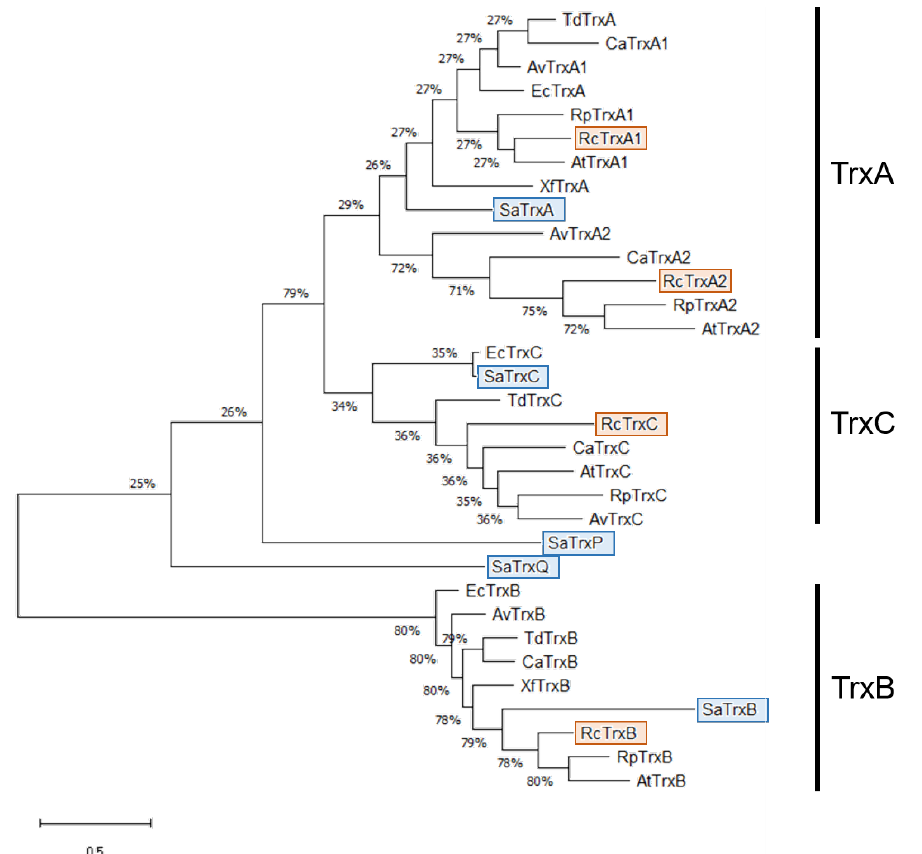
Figure 4. Phylogenic tree based on amino acid sequences of TrxA, TrxC, TrxP, TrxQ, and TrxB homologs. Red and blue boxes indicate the genes of R. capsulatus and S. aureus , respectively. Phylogenetic analysis was performed using the ClustalX [34] and MEGA [35] programs. The tree was generated using the maximum parsimony method. The first two letters of the protein name indicate the bacterium: Rc, Rhodobacter capsulatus ; Sa, Staphylococcus aureus ; Td, Thiobacillus denitrificans ; Ca, Comamonas aquatica ; Av, Allochromatium vinosum ; Ec, Escherichia coli ; Rp, Rhodopseudomonas palustris ; At, Agrobacterium tumefaciens ; Xf, Xylella fastidiosa . Sequences of TrxB proteins were used as the outgroup. Accession numbers of each gene are as follows; EcTrxA (WP_097403417), EcTrxB